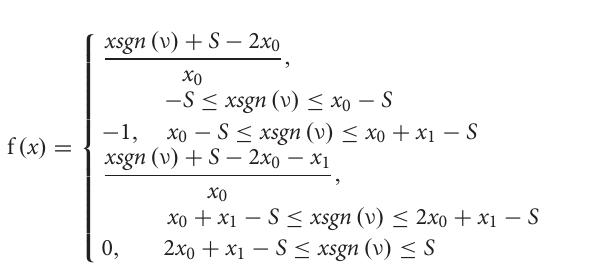
FIGURE 8 | Load displacement curve of MRCSD under different working conditions. (A) Amplitude of 4 mm, current of 0 A. (B) Amplitude of 60 mm, frequency of 0.1 Hz.